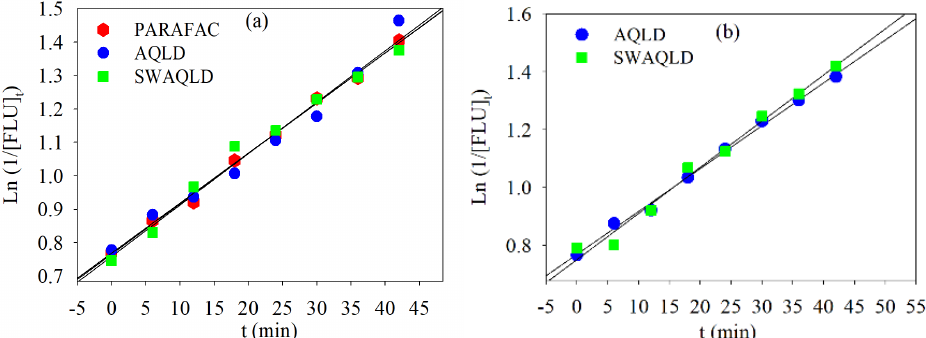
Figure 5. The plot of the natural logarithm of reciprocal of relative concentration (Ln(1/[FLU] t )) versus time (t) for PARAFAC, AQLD, and SWAQLD in the case of free-interference water samples and a rank of 3 ( a ) or 4 ( b ).